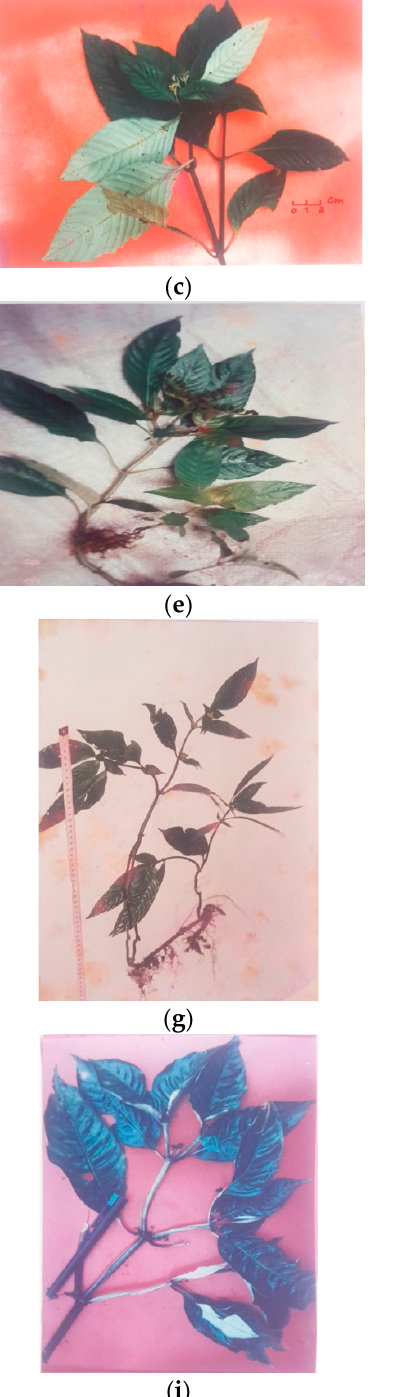
Figure 2. Photo collections of Ophiorrhiza species. ( a ) Ophiorrhiza communis [13]. ( b ) Ophiorrhiza sp. ( ex. Gunung Singgalang) [14]. ( c ) Ophiorrhiza “Siberida DA-RT 6030” [15]. ( d ) Ophiorrhiza sp. (ex. Sako, TNKS) [16]. ( e ) Ophiorrhiza longiflora BI. [17]. ( f ) Ophiorrhiza cf. kunstlery King. [18]. ( g ) Ophiorrhiza ex. Padang Panjang [19,20]. ( h ) Ophiorrhiza “DA-RT 7895” [21]. ( i ) Ophiorrhiza “Air Sirah DA-RT 6604” [22]. ( j ) Ophiorrhiza “Sako DA-RT 7577” [16] .